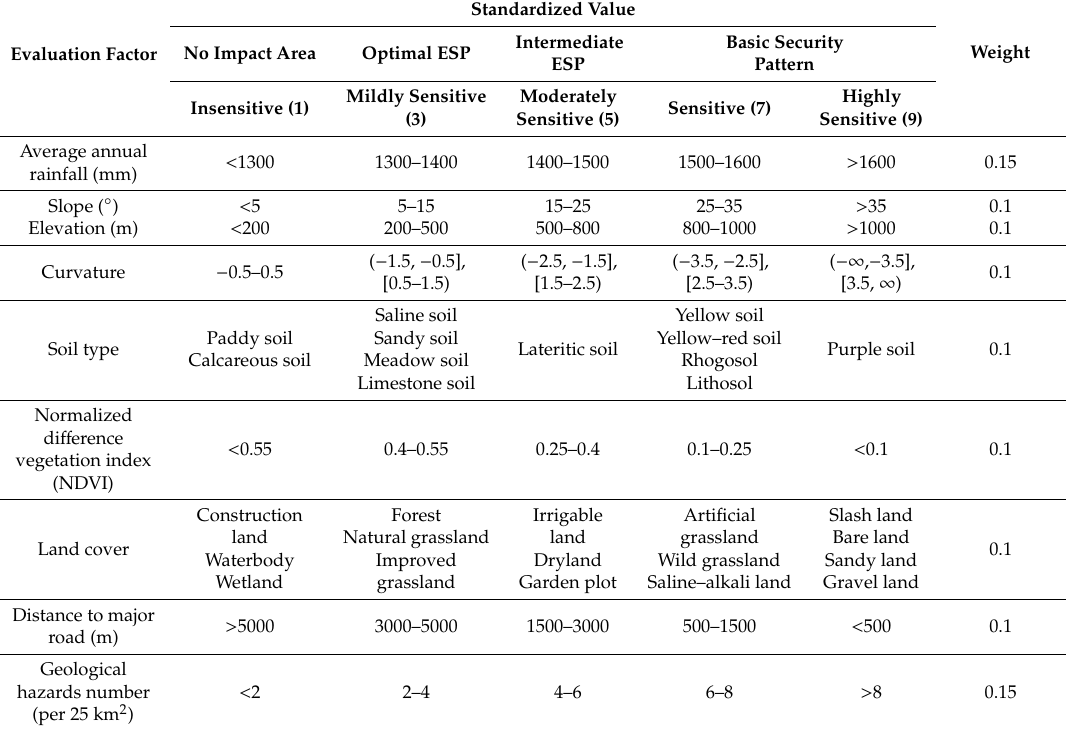
Table 6. Criteria for geology ESP